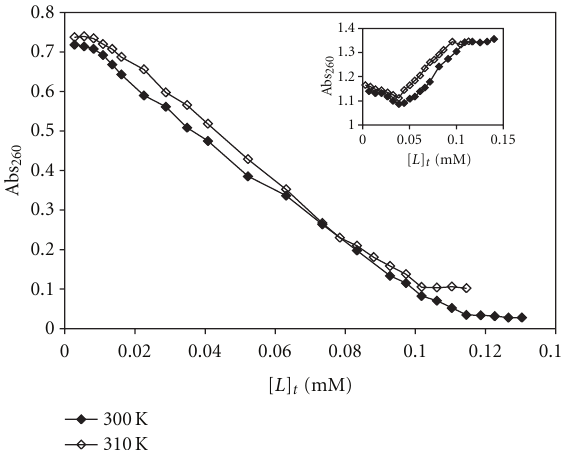
Figure 2: The changes of absorbance of CT-DNA at λ max = 260 nm due to increasing the total concentration of [Pt(bpy)(Oct-dtc)]NO 3 and the inset for [Pd(bpy)(Oct-dtc)]NO 3 , [ L ] t , at constant temper- atures of 300 K and